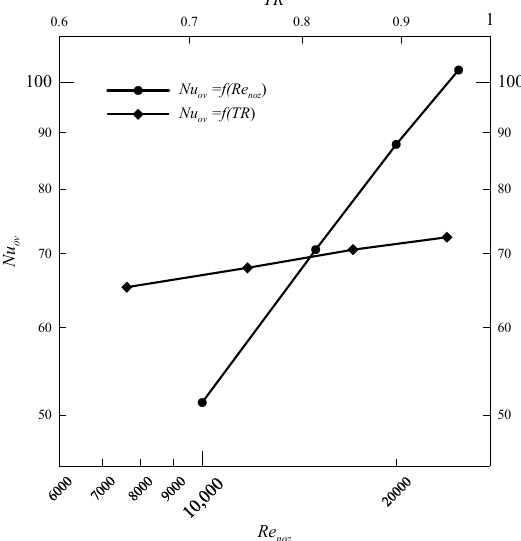
Figure 22. Variations of overall area average Nusselt number as a function of Re noz and TR .